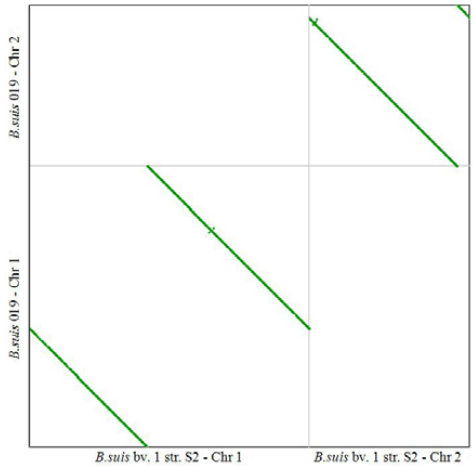
Figure 4. The syntenic map between the B. suis S2 and 019. T he syntenic map between the B. suis S2 and B. suis 019 strain was acquired on the CoGe website. The CDS sequences of B. suis S2 chromosome 1 and 2 used CP006961.1 and CP006962.1 from the GenBank database.